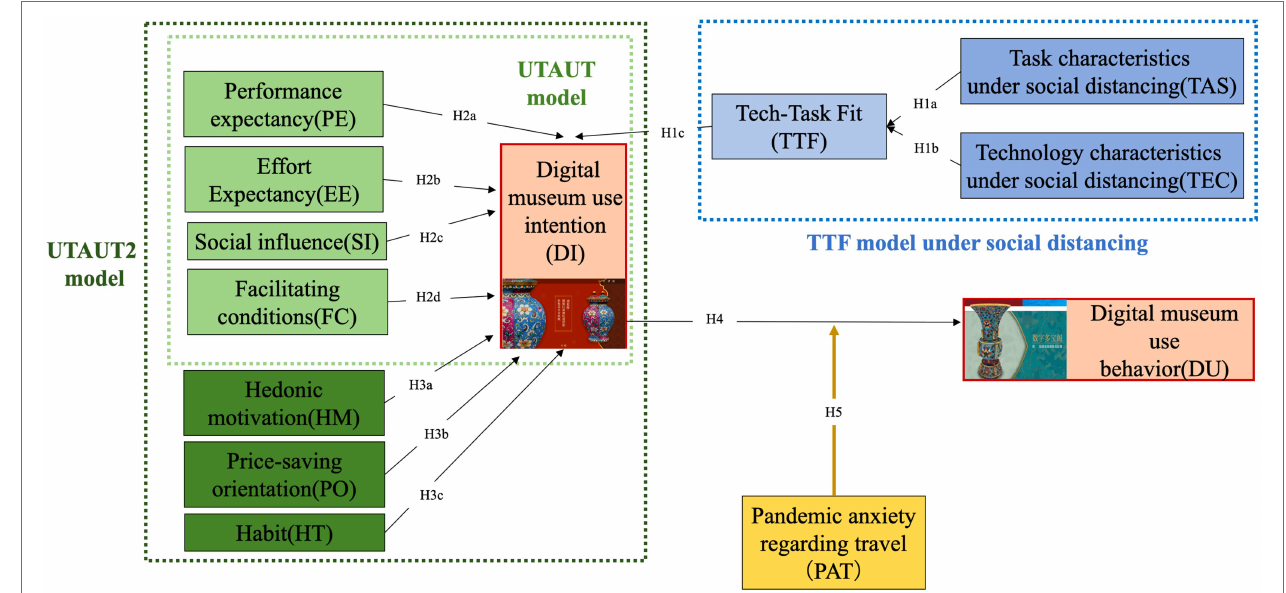
FIGURE 1 | Conceptual